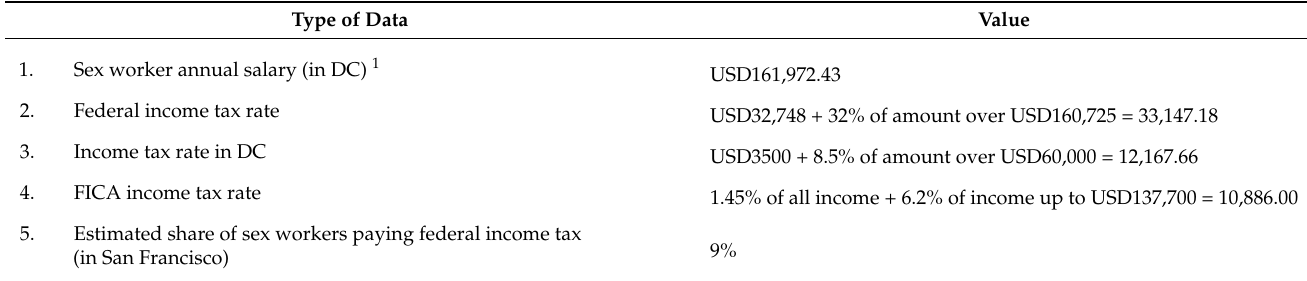
Table 1. Values of data used to calculate income tax generated following decriminalization (monetary values in 2020 USD). Type of